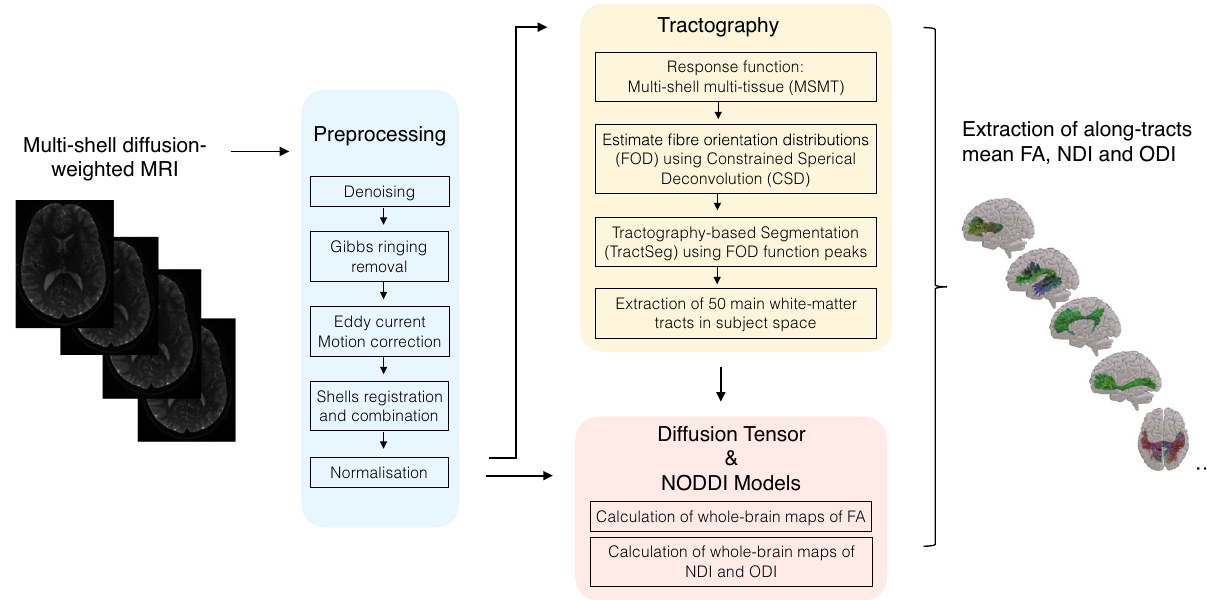
Figure 3. Flowchart summarizing the computation and analysis of microstructural properties of white-matter tracts. Briefly, diffusion-weighted images were preprocessed. Whole-brain multi-shell multi-tissue constrained spherical deconvolution (MSMT-CSD) was extracted and fibre orientation distribution (FOD) function peaks map were input into Tractography-based Segmentation (TractSeg) to extract the main white-matter tracts in subject space. Mean fractional anisotropy (FA), neurite density index (NDI) and orientation dispersion index (ODI) were then extracted along each track by applying the diffusion tensor and NODDI